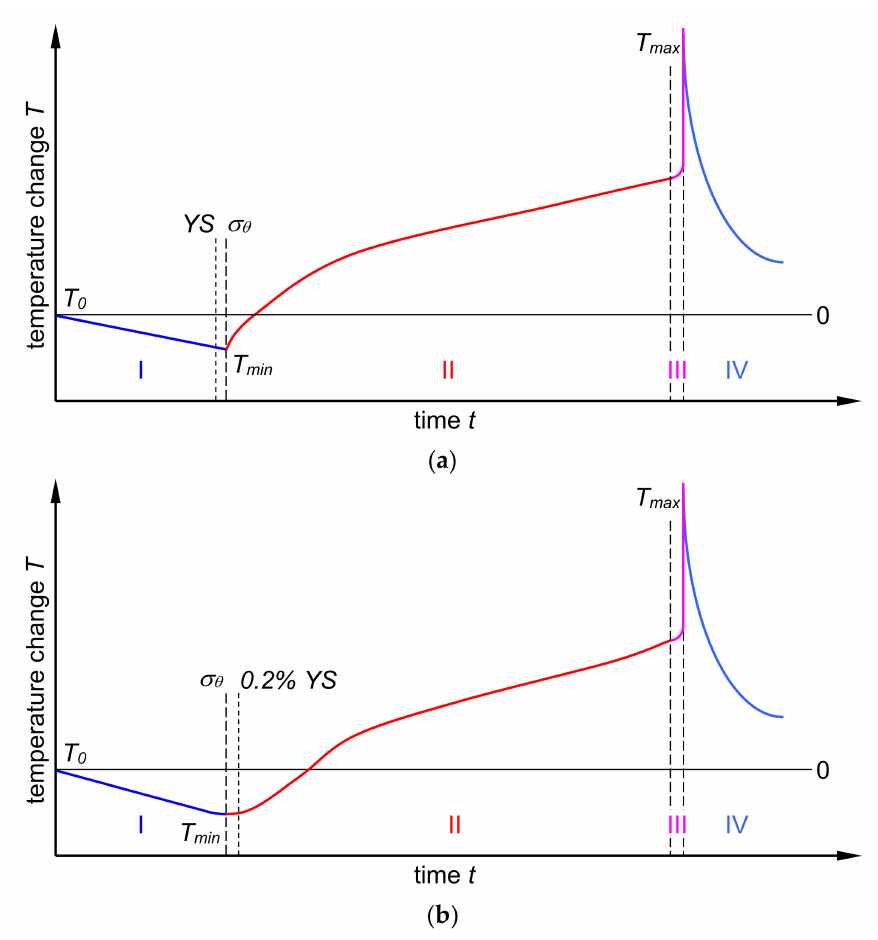
Figure 14. Schematic representation of the course of temperature change during the monotonic tension test of the material featuring a clear yield strength ( a ) and no clear yield strength ( b